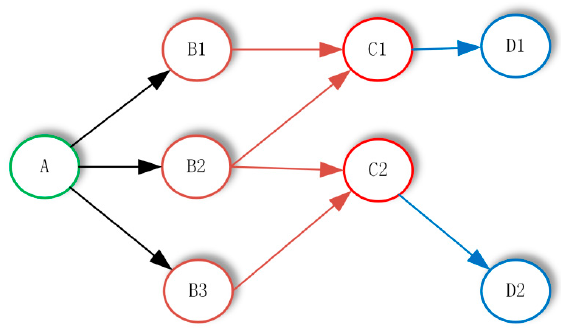
Figure 3. The node’s energy consumption.